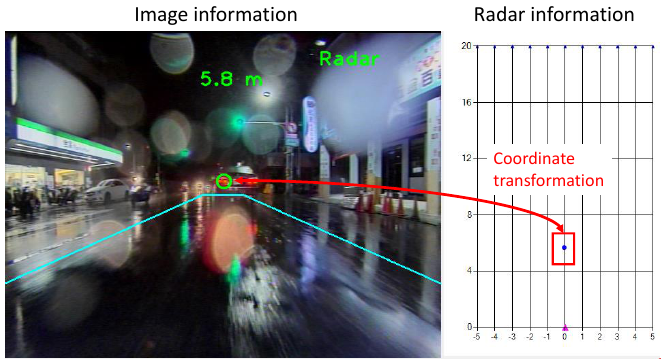
Figure 20. Sensor fusion compensate radar failure.